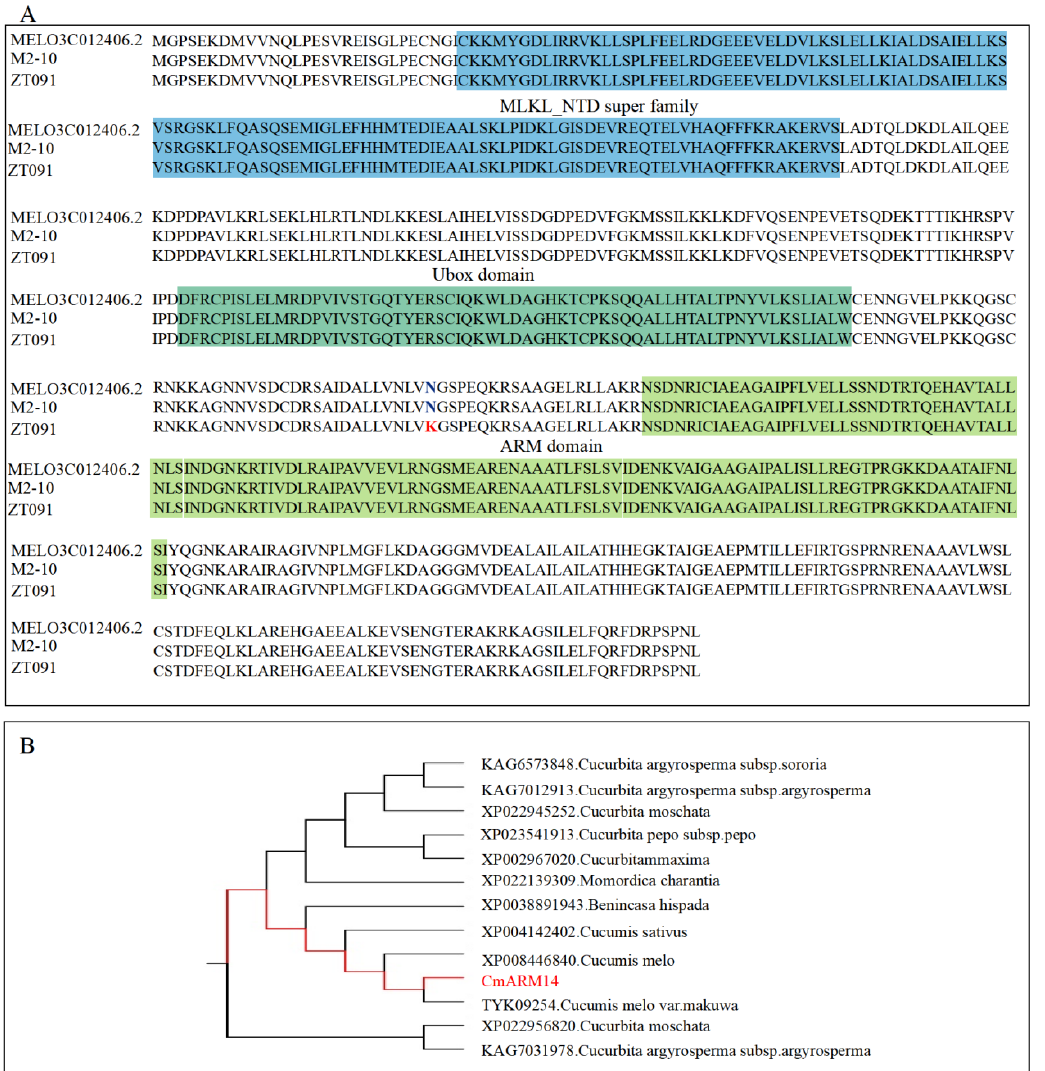
Figure 4. Phylogenetic analysis of the MELO3C012406 gene. ( A ): Alignment of protein sequences of reference gene sequences, M2-10 and ZT00091, and the MELO3C012406 gene. The colors are labeled as the structural domains contained in the gene. ( B ): Phylogenetic analysis with other Cucurbitacea plants viz., Cucurbita argyrosperma subsp. sororia, Cucurbita argyrosperma subsp. argyrosperma, Cucurbita moschata , Cucurbita pepo subsp. pepo, Cucurbita mmaxima , Benincasa hispada , Cucumis sativus , Cucumis melo , Cucumis melo var. makuwa, and Cucurbita moschata .